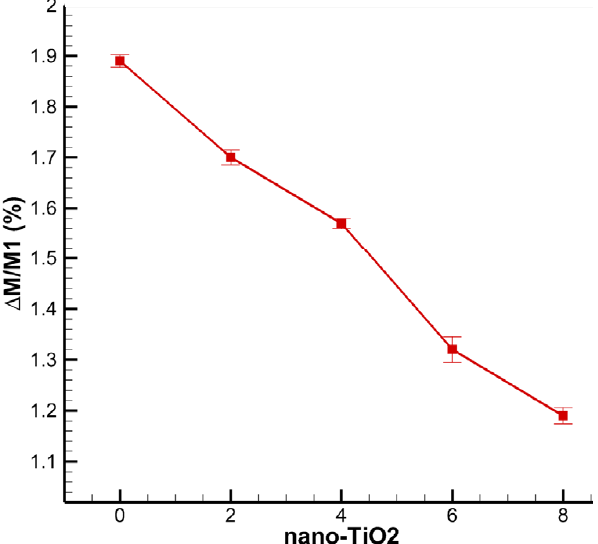
Fig. 2. Effect of nano-TiO 2 addition on improvement of hydration resistance of MgO-CaO refractories [2]. J. Water Environ. Nanotechnol., 2(3): 206-222, Summer 2017